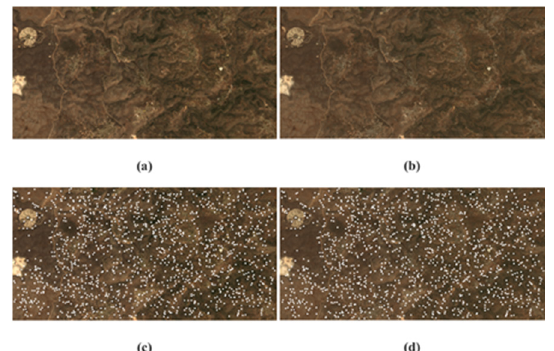
Figure 8. RGB composition of the spectral images used in Experiment 2: ( a ) Landsat 8 and ( b ) Sentinel-2A. The white dots in ( c ) and ( d ) represent the detected invariant points (IPs) in this pair of images, respectively.